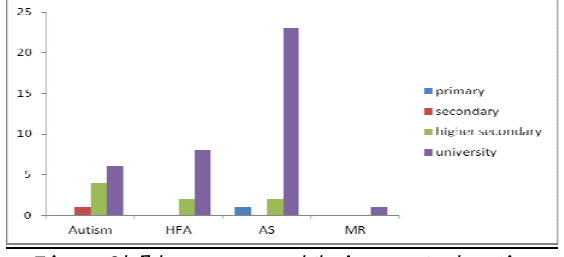
Fig. 5: Children group and their parent education While concerning about the economic Fig. 3: Savant skills of the children in our status; 81.8% of autism children, 90% of HFA study children and 84.6% of AS children’s